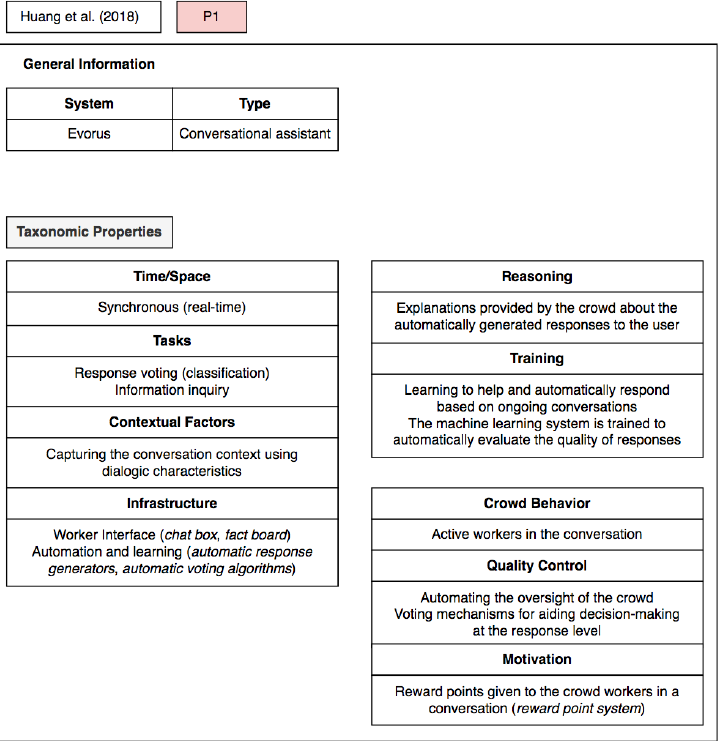
Figure 4. Example of a taxonomic scheme used to classify a crowd-AI interaction scenario [39].